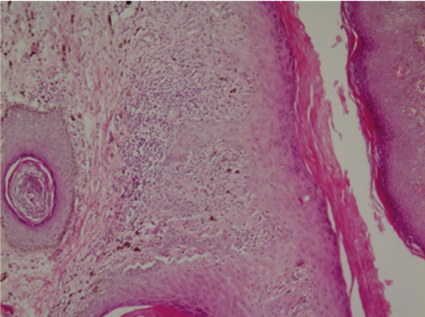
Figure 2: Photomicrograph ( × 40) of genital lichen planus with fulfillment of diagnostic histopathological criteria.